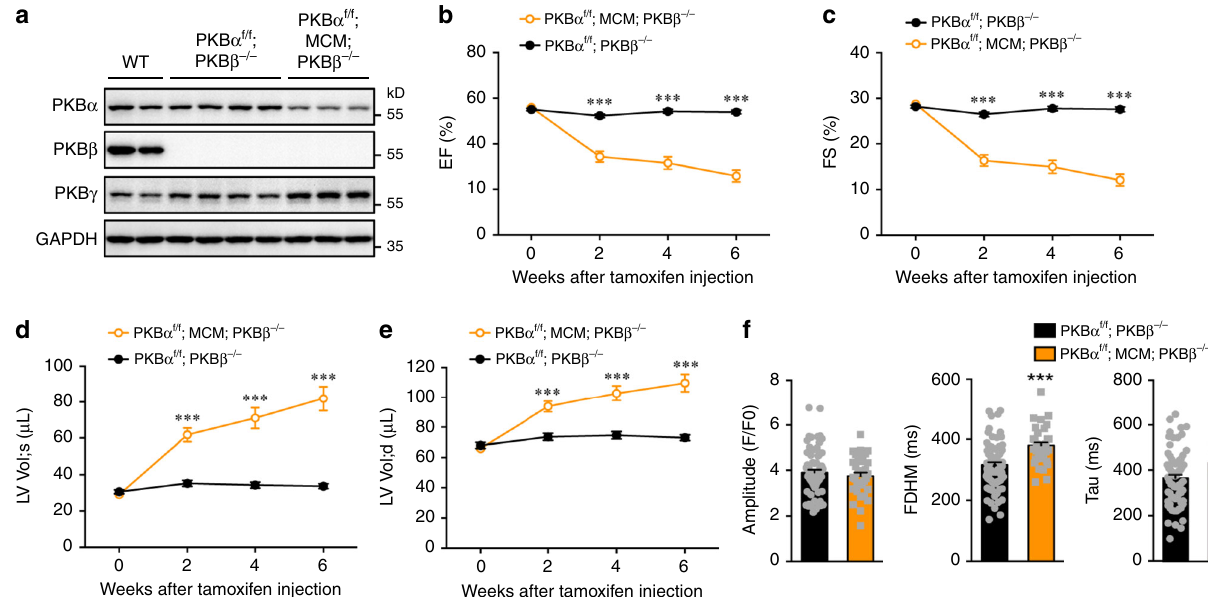
Fig. 1 Effects of PKB α / β deletion in the heart on cardiac function and calcium transients in primary cardiomyocytes. a PKB α , β and γ protein expression in the heart of male PKB α f/f ;MCM;PKB β − / − mice at 8 weeks after tamoxifen induction. b – e Ejection fraction (EF) ( b ), fractional shortening (FS) ( c ), systolic left ventricular volume (LV Vol;s) ( d ), and diastolic left ventricular volume (LV Vol;d) ( e ) were measured via echocardiography in the male PKB α f/f